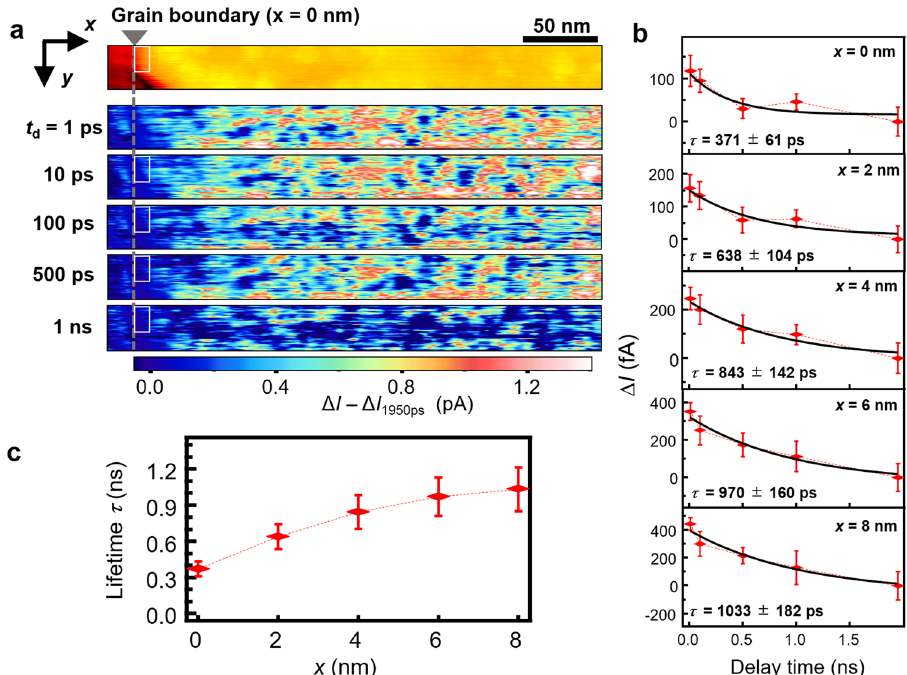
Fig. 6 TR-MP-STM measurement results obtained at a grain boundary. a STM image corresponding to the area shown in Fig. 3a and TR-MP- STM measurement results obtained over the surface for the delay times of 1, 10, 100, 500, 1000, and 1950 ps. 1950 ps is the limit of the delay time of our system used here. Here, the values in the image obtained for 1950 ps was subtracted from the other images. The measurement conditions were V s = − 3 V, I set = 10 pA, fl uence 13 μ J/cm 2 and center wavelength 633 nm, and the excitation energy was adjusted to the peak of the exciton resonance spectrum of WS 2 . b TR-MP-STM spectra obtained in the white square shown in a. x indicates the distance from the boundary. The 56 spectra for each x were averaged. Lifetimes obtained by fi tting are shown in each fi gure. c Lifetime as a function of x. As can be seen in Fig. 3a, I d was measured when the probe was in the area to the right of the right GB edge. Therefore, to reduce the in fl uence of the structures in GB, this measurement was performed on the right side of the GB edge. The error bars in b are the standard deviation of the 56- point values in the y direction at each x point in the white square shown in a . The error bars in c are the fi tting errors obtained in b